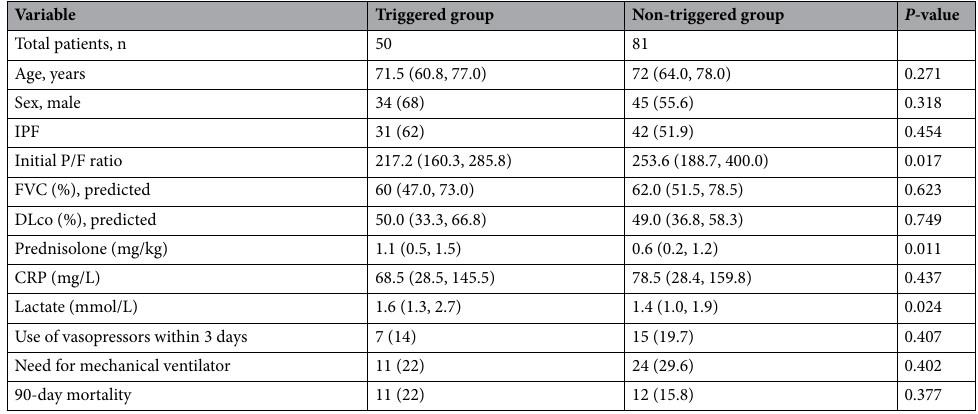
Table 2. Comparison of baseline characteristics between triggered and non-triggered AE-ILD groups. Data are presented as mean and standard deviation, median and interquartile range, or frequency (%). IPF idiopathic pulmonary fibrosis, AE-ILD acute exacerbation of interstitial lung disease, FVC forced vital capacity, DLco diffusing capacity of carbon monoxide, P/F ratio partial pressure of oxygen in arterial blood (PaO 2 )/ fraction of inspired oxygen (FiO 2 ) ratio, CRP C-reactive protein.